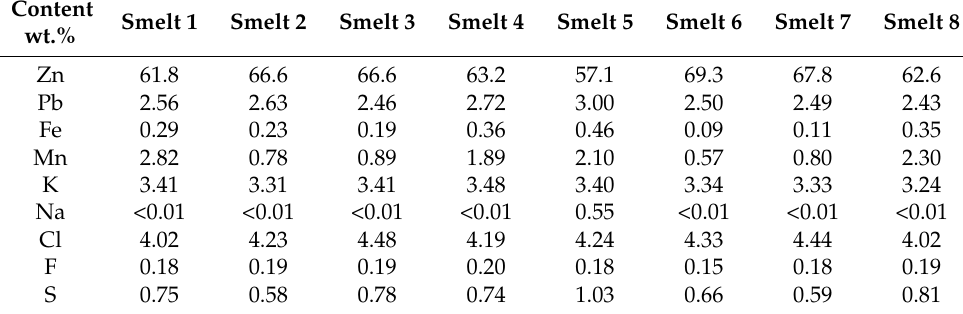
Table 3. Chemical analysis of bag filter dust. Content